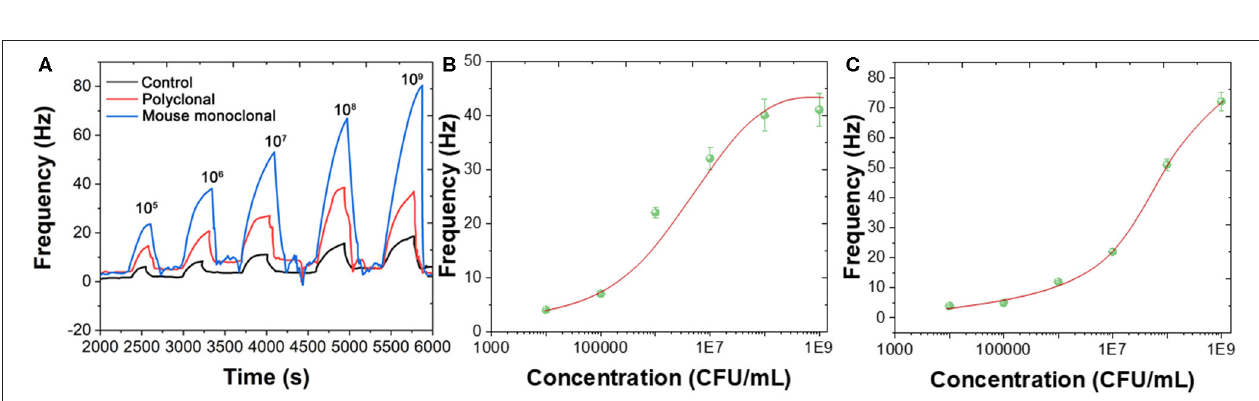
FIGURE 3 | (A) Frequencies recorded at QCM when different concentrations of B. bifidum introduced using polyclonal antibody immobilized sensor, mouse monoclonal antibody immobilized sensor, and mouse IgG antibody immobilized sensor. Plots of Frequency vs. concentrations of B. bifidum using (B) polyclonal antibody immobilized sensor and (C) mouse monoclonal antibody immobilized sensor.